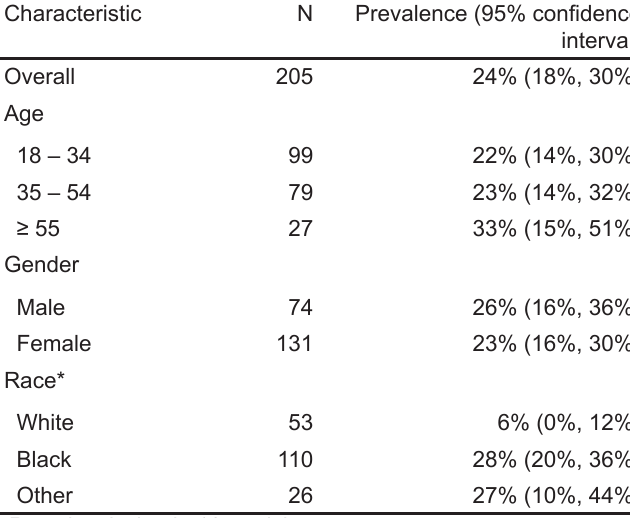
Table 2 . Prevalence of H. pylori Infection in study sample by demographic characteristics.